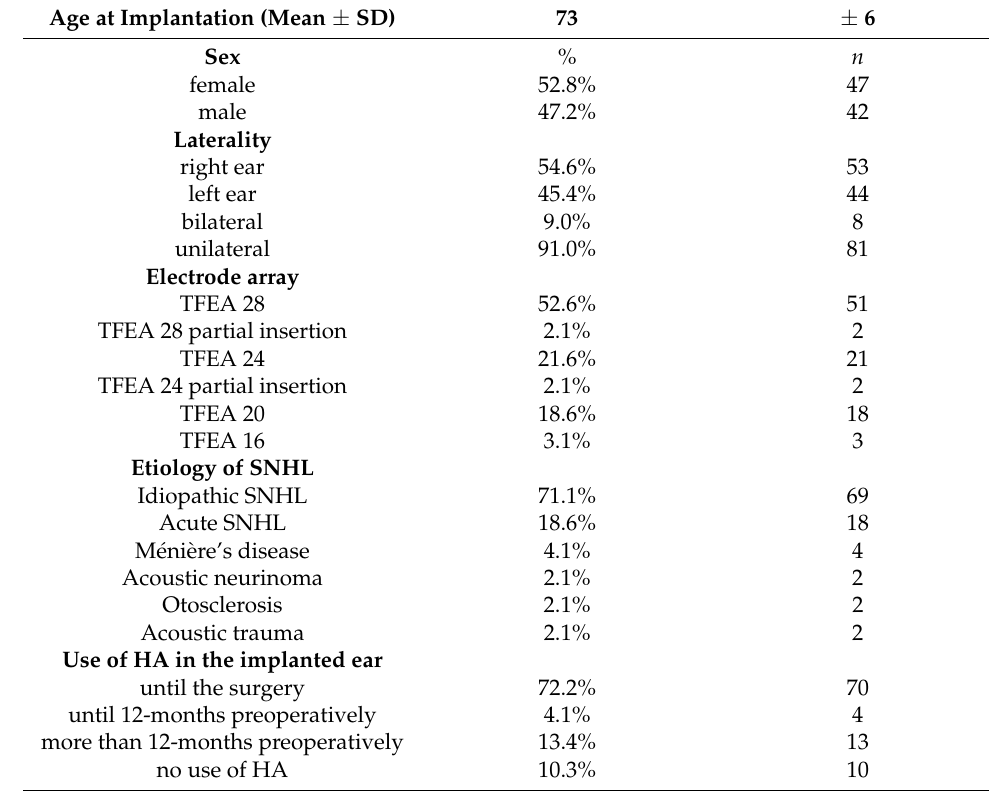
Table 1. Patients’ demographics of 89 patients and 97 CI electrode